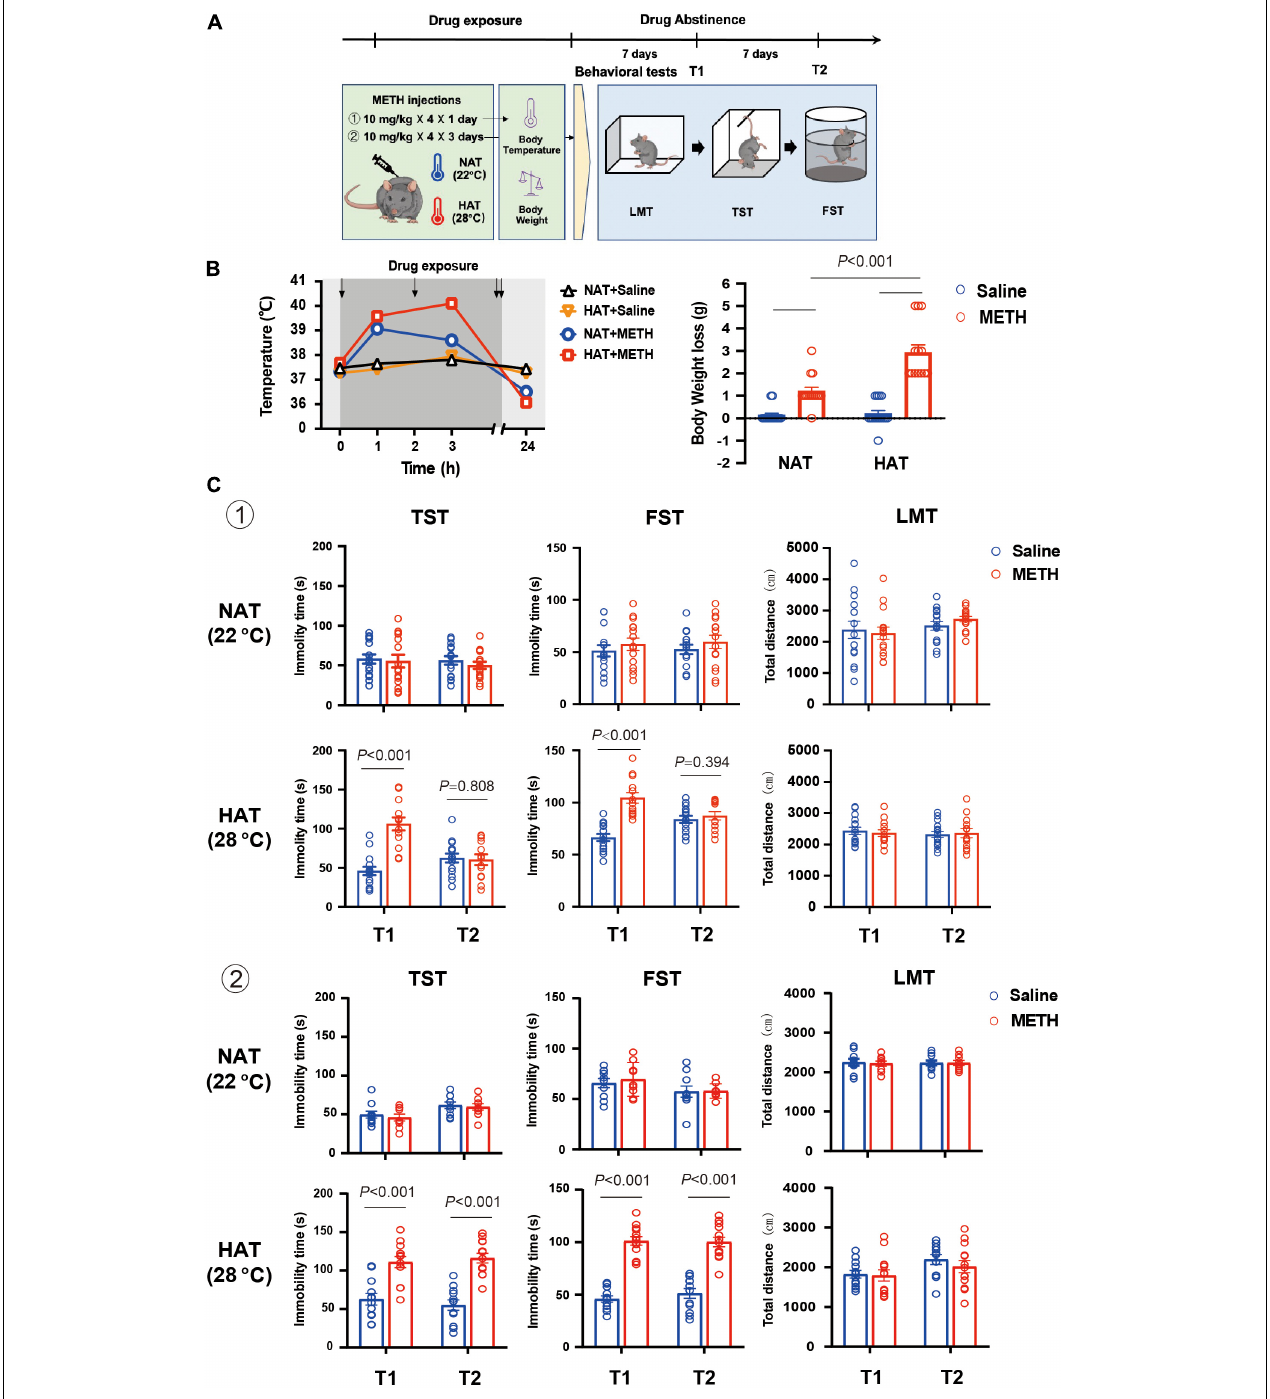
FIGURE 1 | Methamphetamine (METH) exposure induced hyperthermia and depression-like behaviors in an ambient temperature and dose-dependent manner. (A) Timeline of drug treatment and behavioral tests. (B) High ambient temperature aggravated METH-induced hyperthermia (left) and body weight loss (right). Four doses of METH (10 mg/kg i.p.) treatments were given to mice each within 2-h interval. The arrows represented drug exposure. Body temperature was determined at 0-, 1-, 3-, and 24-h after the first METH treatment, and body weight loss was calculated at 24-h after drug treatment. ( n = 15, 15, 15, and 13) (C) METH exposure (a: 10 mg/kg × 4 injections × 1 day; b: 10 mg/kg × 4 injections × 3 days) under high ambient temperature (28 ◦ C) induced depression-like behaviors in mice. The behavioral tests including locomotion test (LMT), tail suspension test (TST), and forced swimming test (FST) were performed 7 (T1) and 14 (T2) days after METH treatments ( a: n = 15 and 15 for NAT, n = 15 and 13 for HAT; b: n = 10 and 9 for NAT, n = 12 and 13 for HAT). Data are expressed as the mean ± SEM.